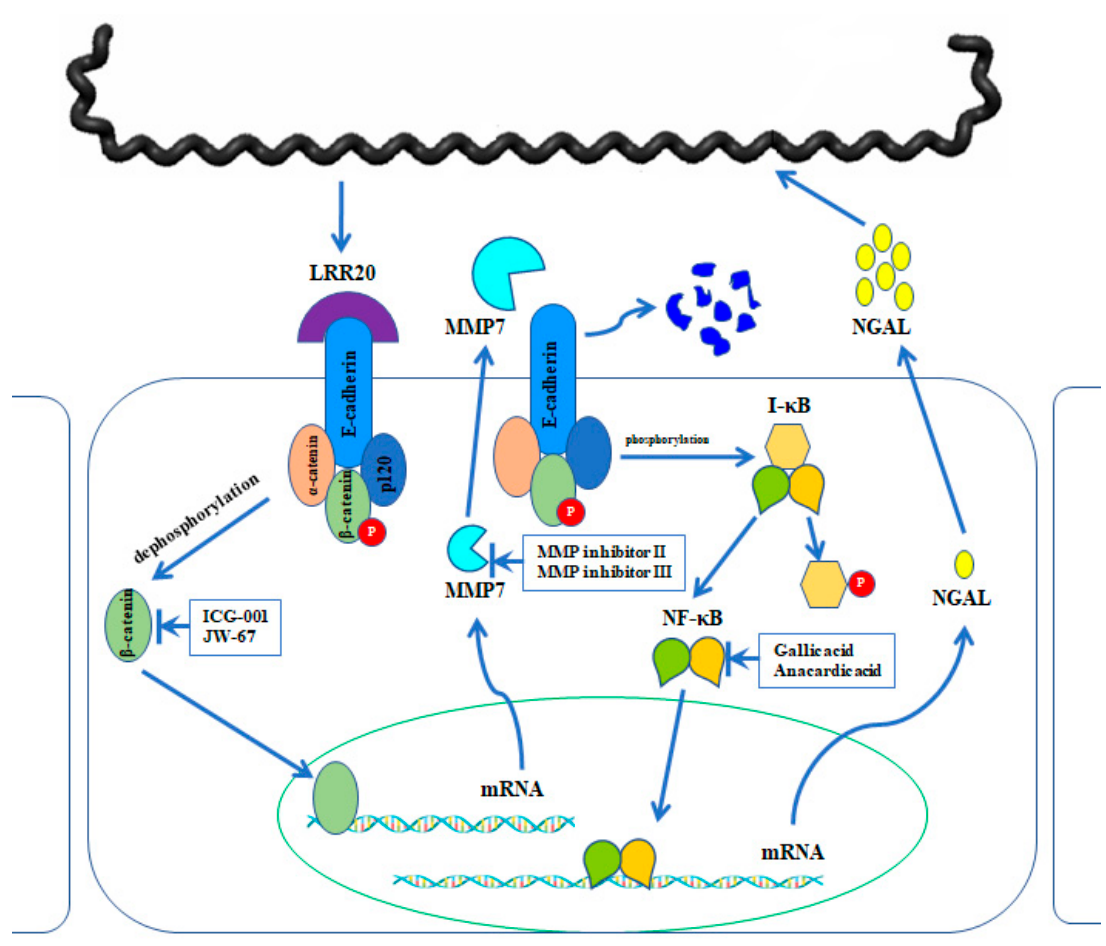
Figure 10. Proposed working model for the signal transduction crosstalk between E-cadherin/ β -catenin and NF- κ B signaling pathways. Leptospira colonizes the kidney epithelial cells through various adhesins. Recombinant LRR20 (rLRR20) protein interacts with E-cadherin and consequently activates β -catenin. The nuclear translocation of activated β -catenin promotes the expression of its target genes, including MMP7 . Subsequently, MMP7 is secreted to the extracellular region. The expression and secretion of MMP7 promote the degradation of E-cadherin on the cell surface and downregulate the cell surface levels of E-cadherin. Meanwhile, the degradation of E-cadherin on the cell surface induces the activation of the NF- κ B:p65 signal transduction pathway, which subsequently promotes the expression of downstream target gene NGAL . The inhibitors used to inhibit the specific targets are shown.